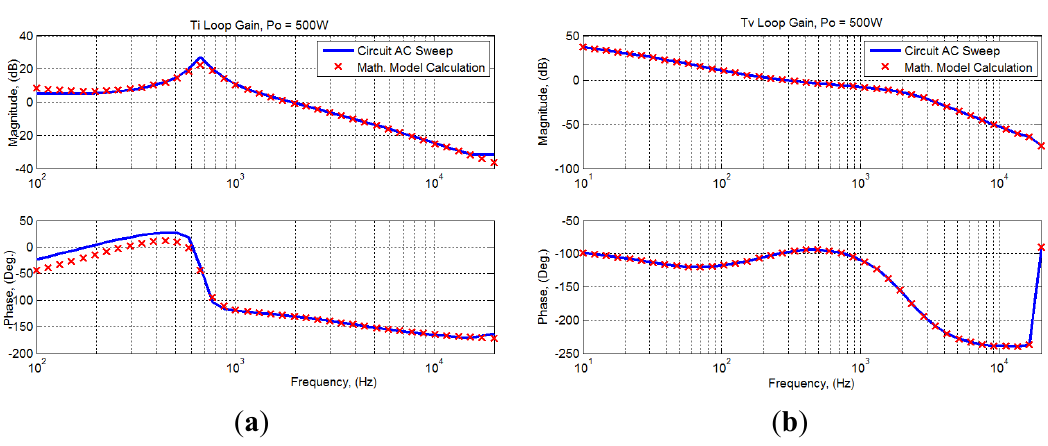
Figure 15. Loop gain frequency responses of compensated in charge mode operation ( a ) current loop and ( b ) voltage loop.